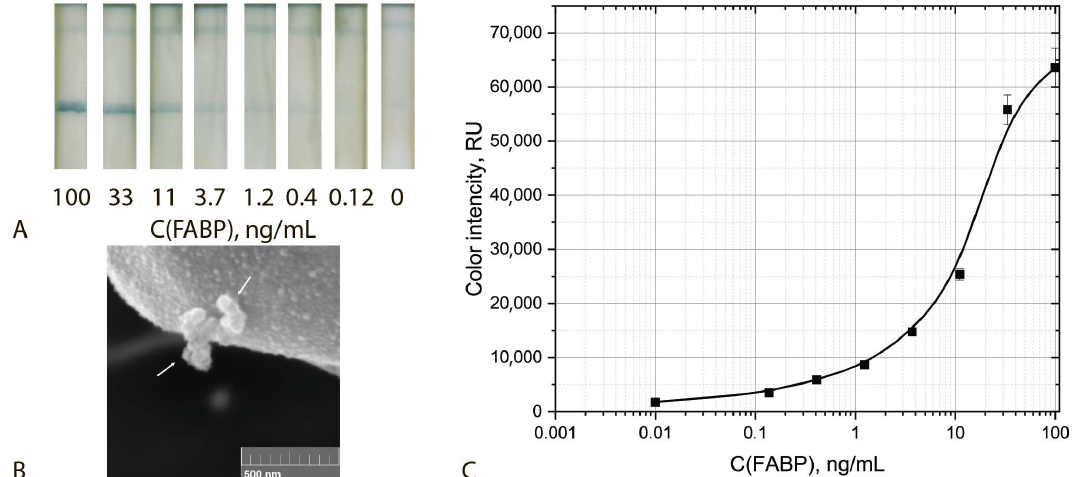
Figure 10. ICA with triple enhancing approaches: appearance of test strips ( A ), SEM image of the sGNFs aggregates bound in the analytical zone ( B ) and calibration curve for FABP detection in serum ( C ) ( n = 5).